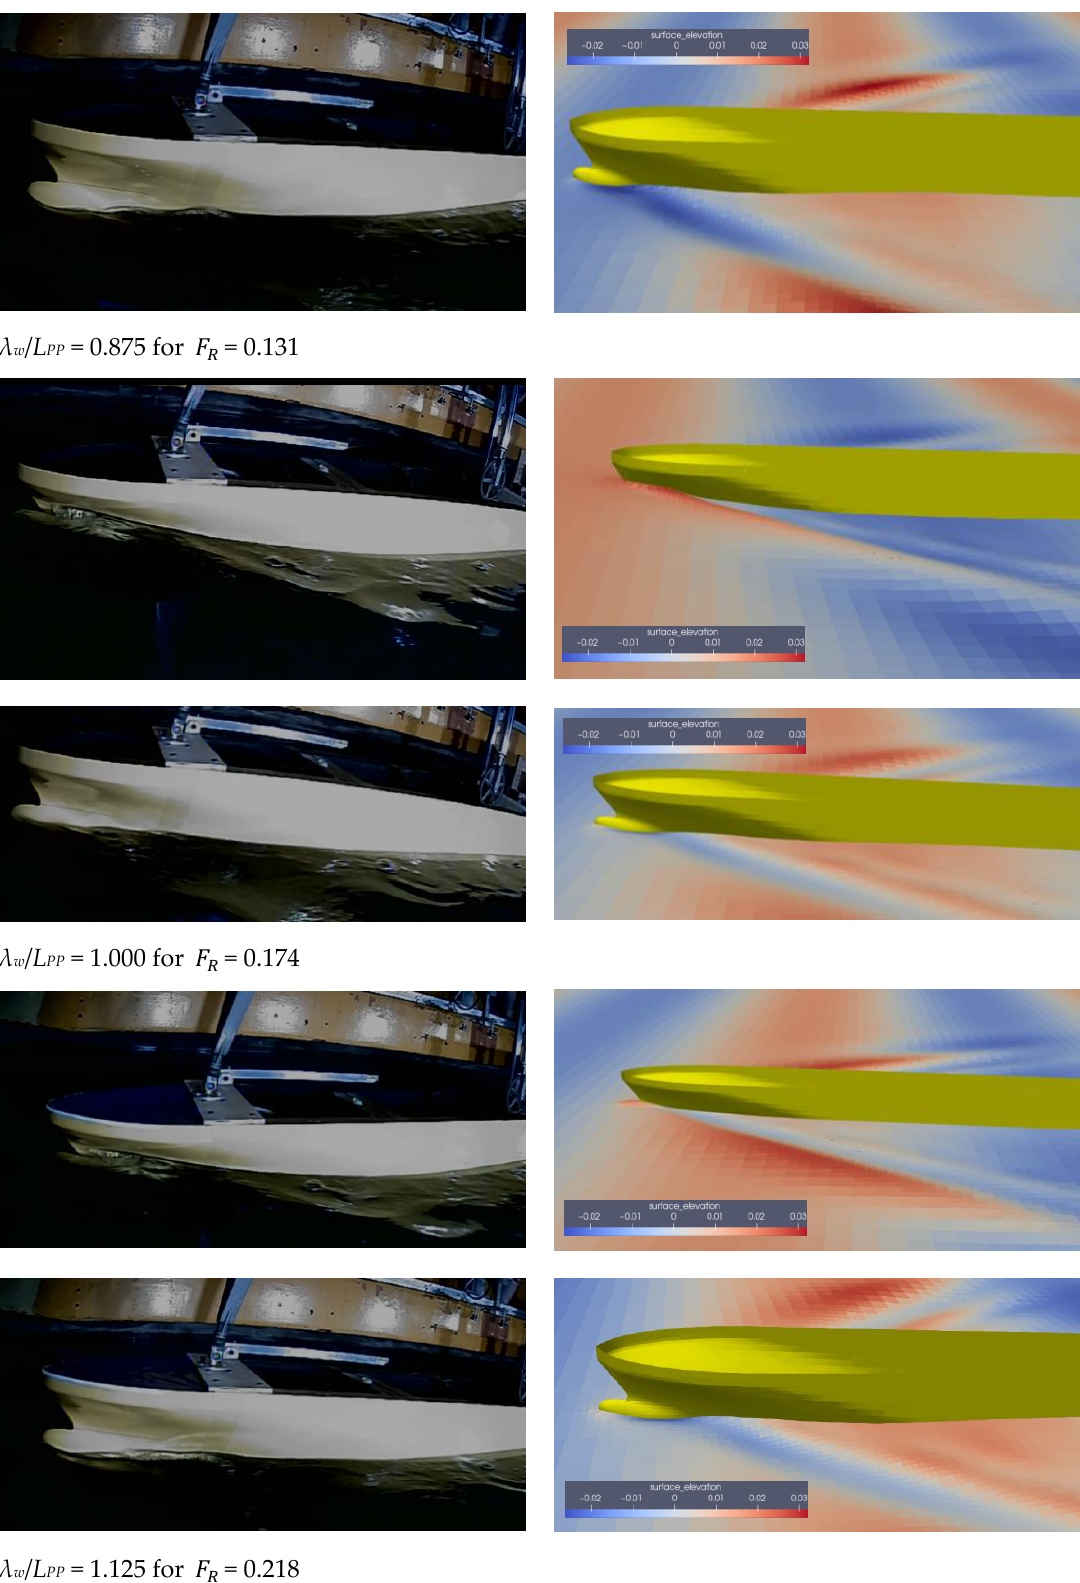
Figure 9. Wave elevation comparison between the experimental tests and numerical simulations.